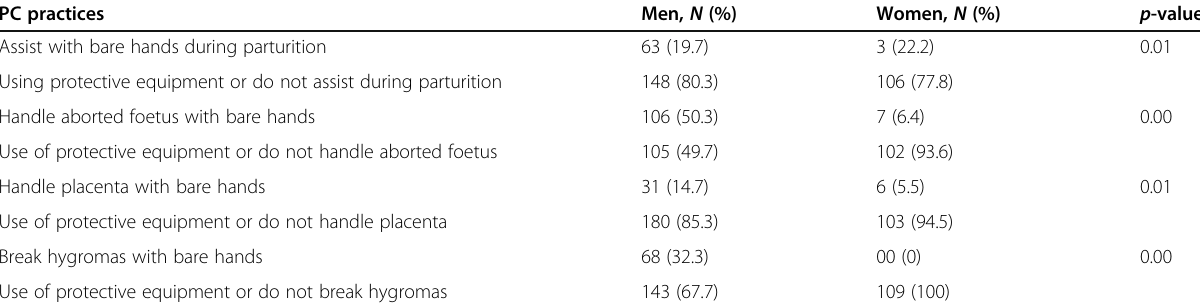
Table 3 Pastoral community behavioural risk factors of brucellosis transmission linked to livestock management PC